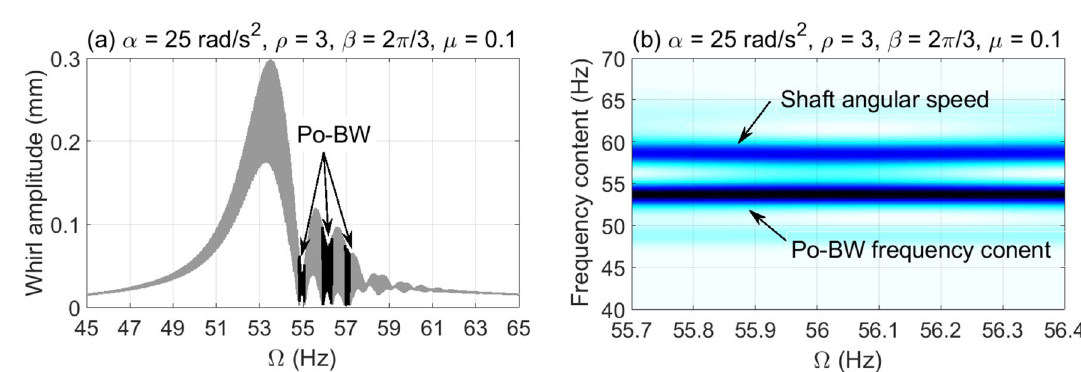
Figure 9. Po-BW zones of rotational speeds of an overhung cracked rotor system shown in the whirl amplitudes in ( a ), and the corresponding wavelet spectrum transform of the second Po-BW zone in ( b ) at 3 rad , and ρ = 3 . µ = 0.1 , α = 5 rad/s 2 , β = 2 π (cid:31)